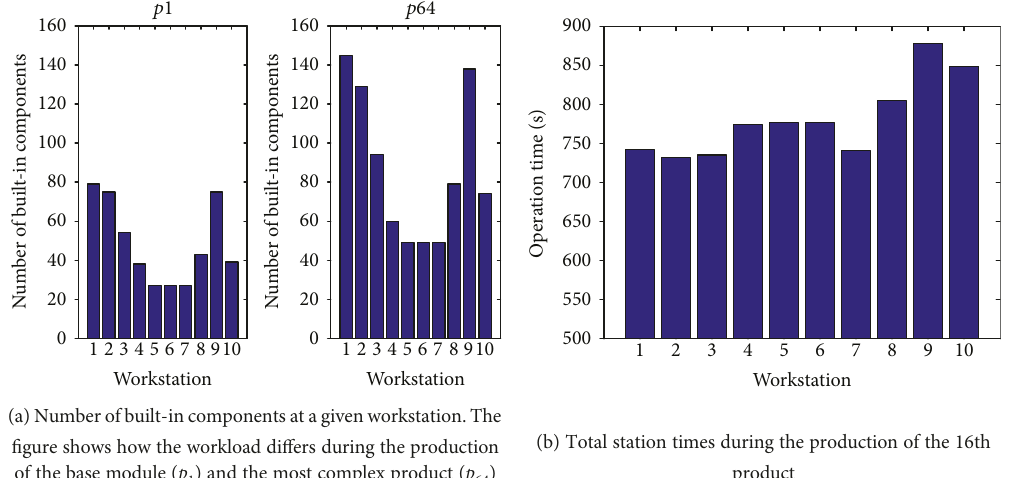
Figure 10: The workloads (number of activities, built-in components, and total activity times) can be easily calculated based on the biadjacency matrices of the proposed model, which supports the balancing of the conveyor